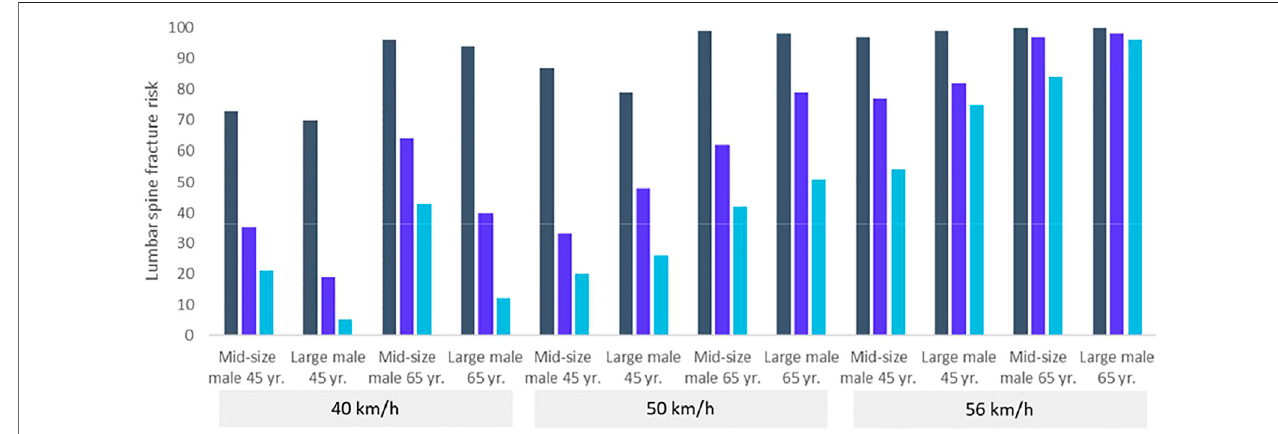
FIGURE6| Lumbarvertebrafractureriskcalculatedaccordingto Eqs1 , 2 forthethreecrashpulseseveritylevels,thetwoHBMsizes,andthetwoages.Theblack columns represent the fi xed seat, the dark blue the passive STLL with a soft stop, and the light blue the adaptive STLL.